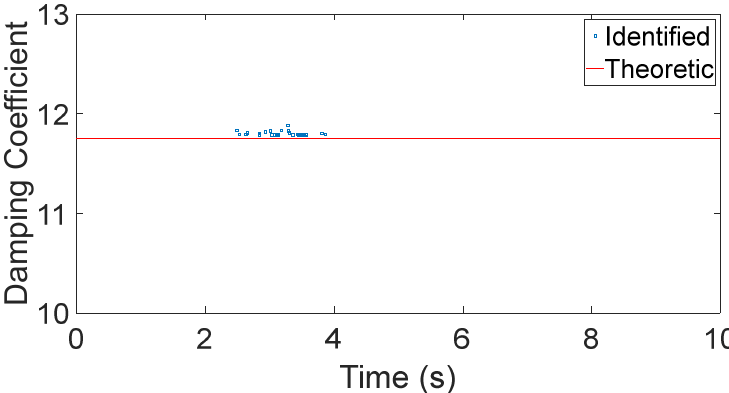
Figure 21. Identified damping coefficient from shake table test of bridge model.